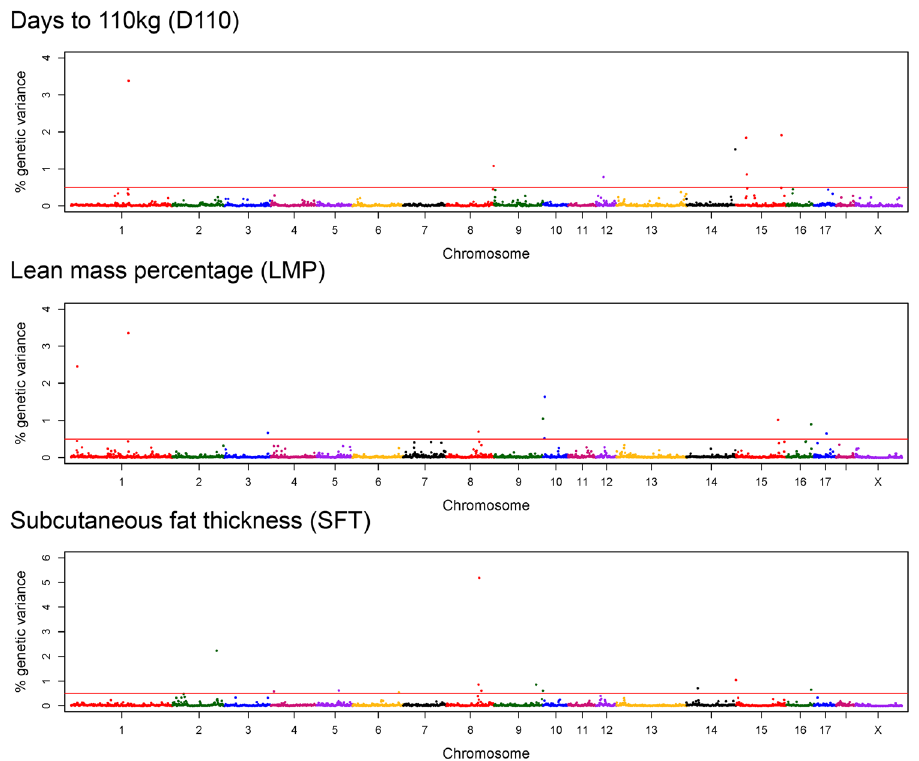
Figure 2. Manhattan plots depicting the proportion of 1 Mb genomic windows to the genetic variance of analysed traits obtained from a Bayesian multi-marker approach (Bayes B). The threshold line represents contributions to the additive genetic variance of traits above